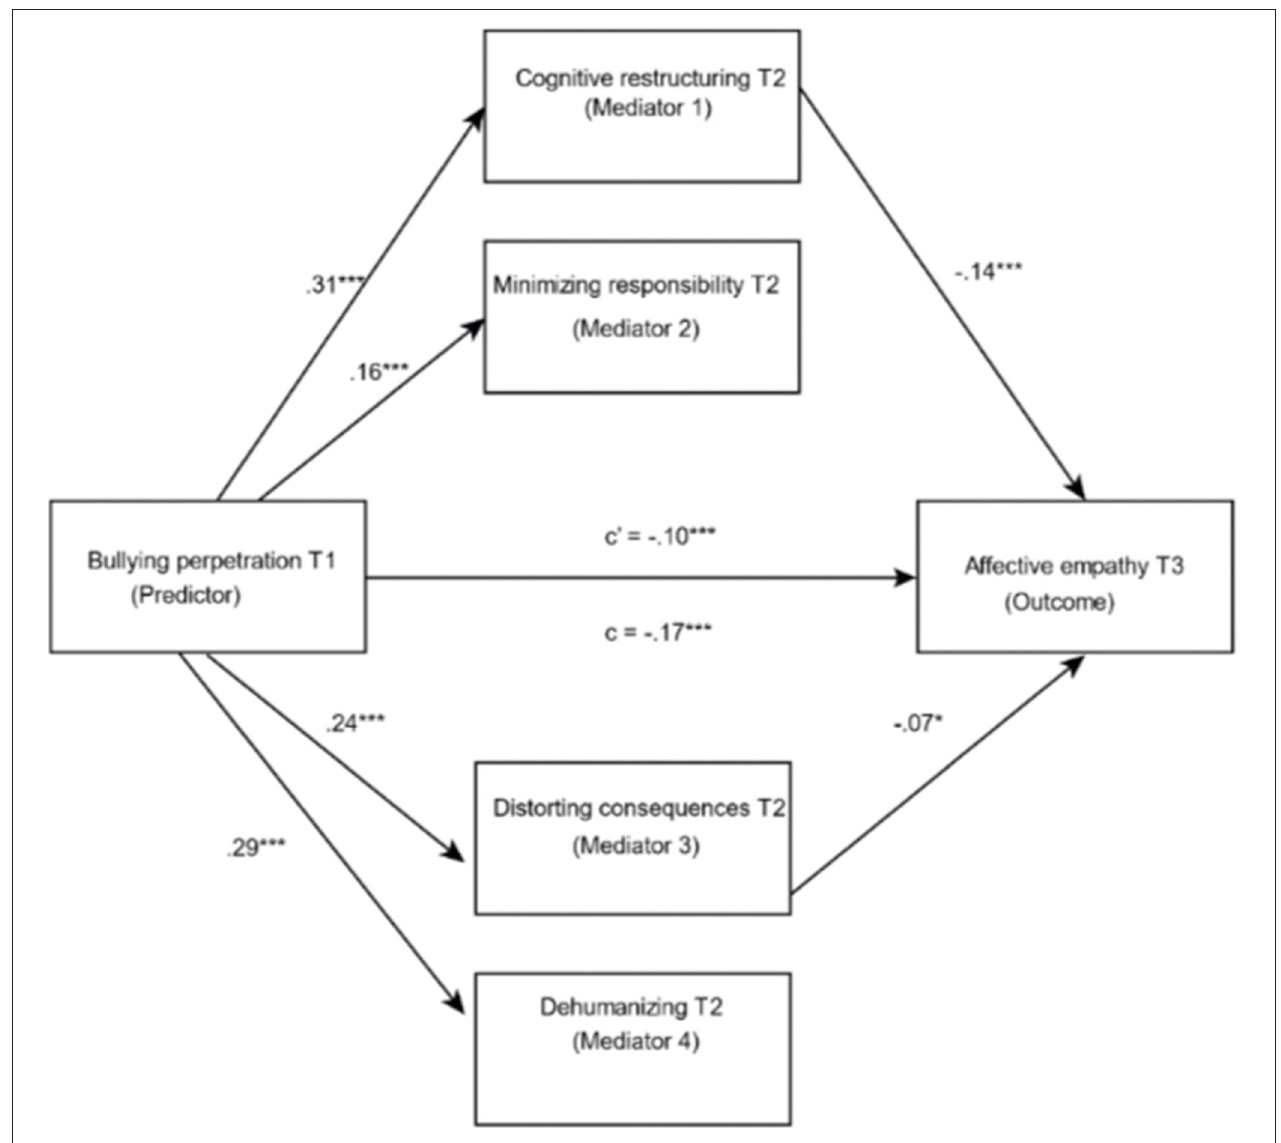
FIGURE 2 | Results in the pathways of the model. * p < 0.05; ** p < 0.01; *** p <